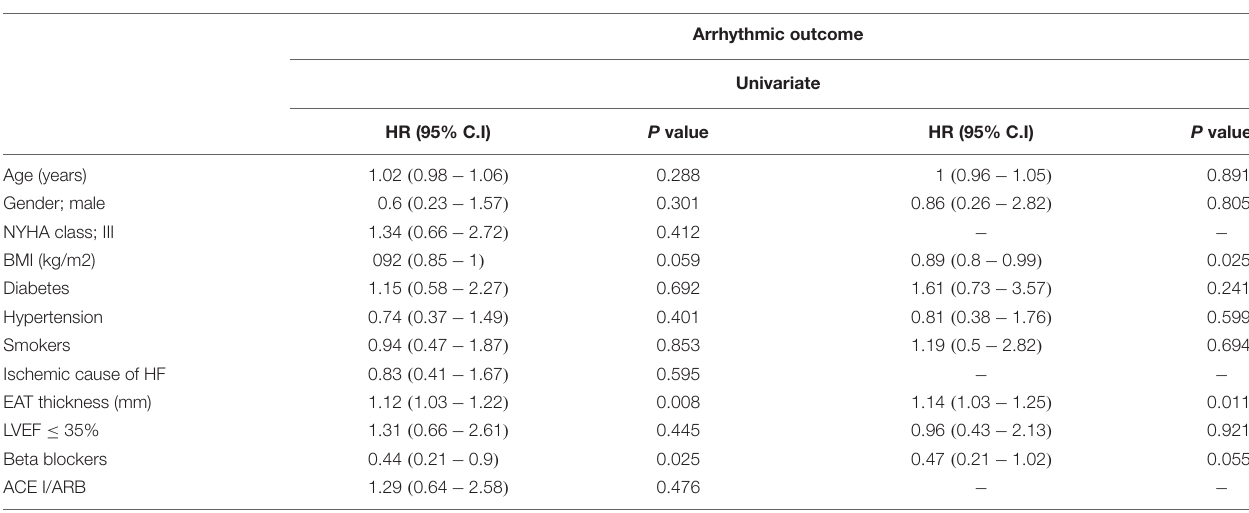
TABLE 3 | Predictors of the arrhythmic outcome.